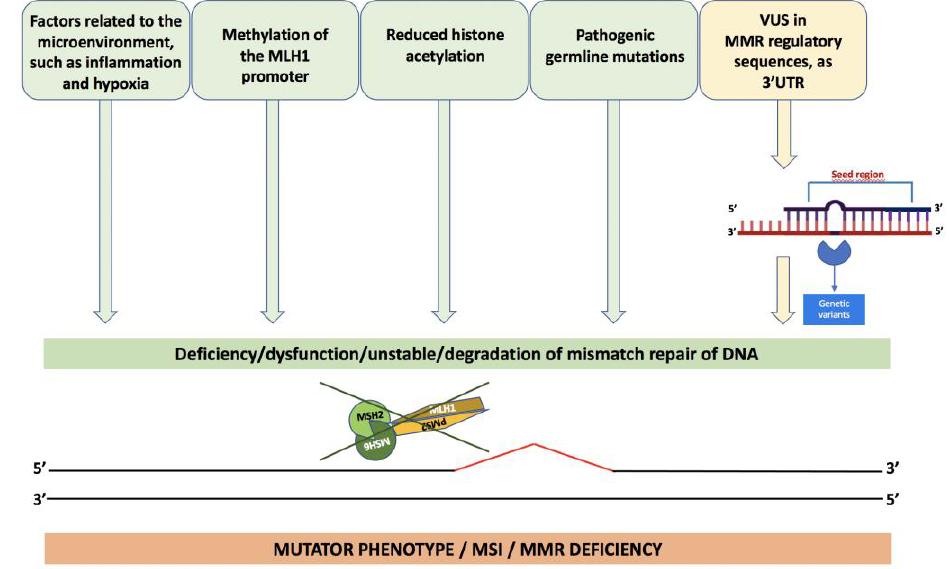
Figure 4. Causes of the loss of expression of MMR genes.